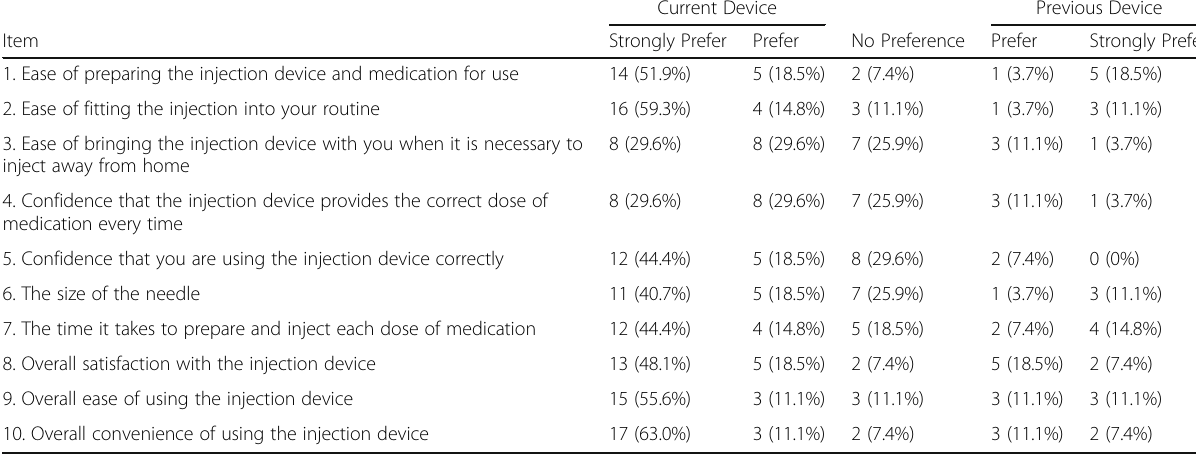
Table 3 Preference Questionnaire: Frequencies and Percentages for Each Response Option ( N = 27)